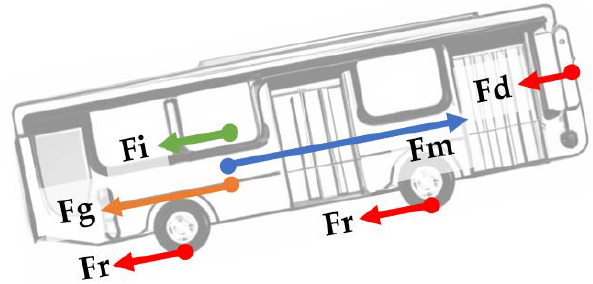
Figure 1. Vehicle accelerating uphill.